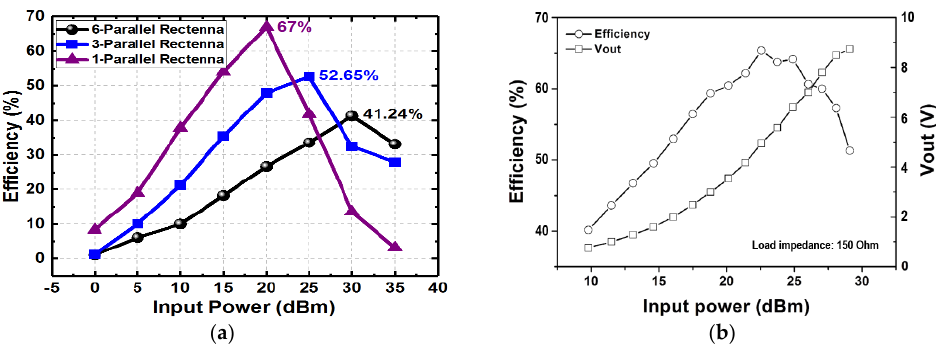
Figure 12. Measured efficiency vs. input power level of the proposed RF EH system ( a ) Different number of parallel rectenna stages and ( b ) Output voltages. Reprint with permission [4775431338148]; 2020, IEEE.